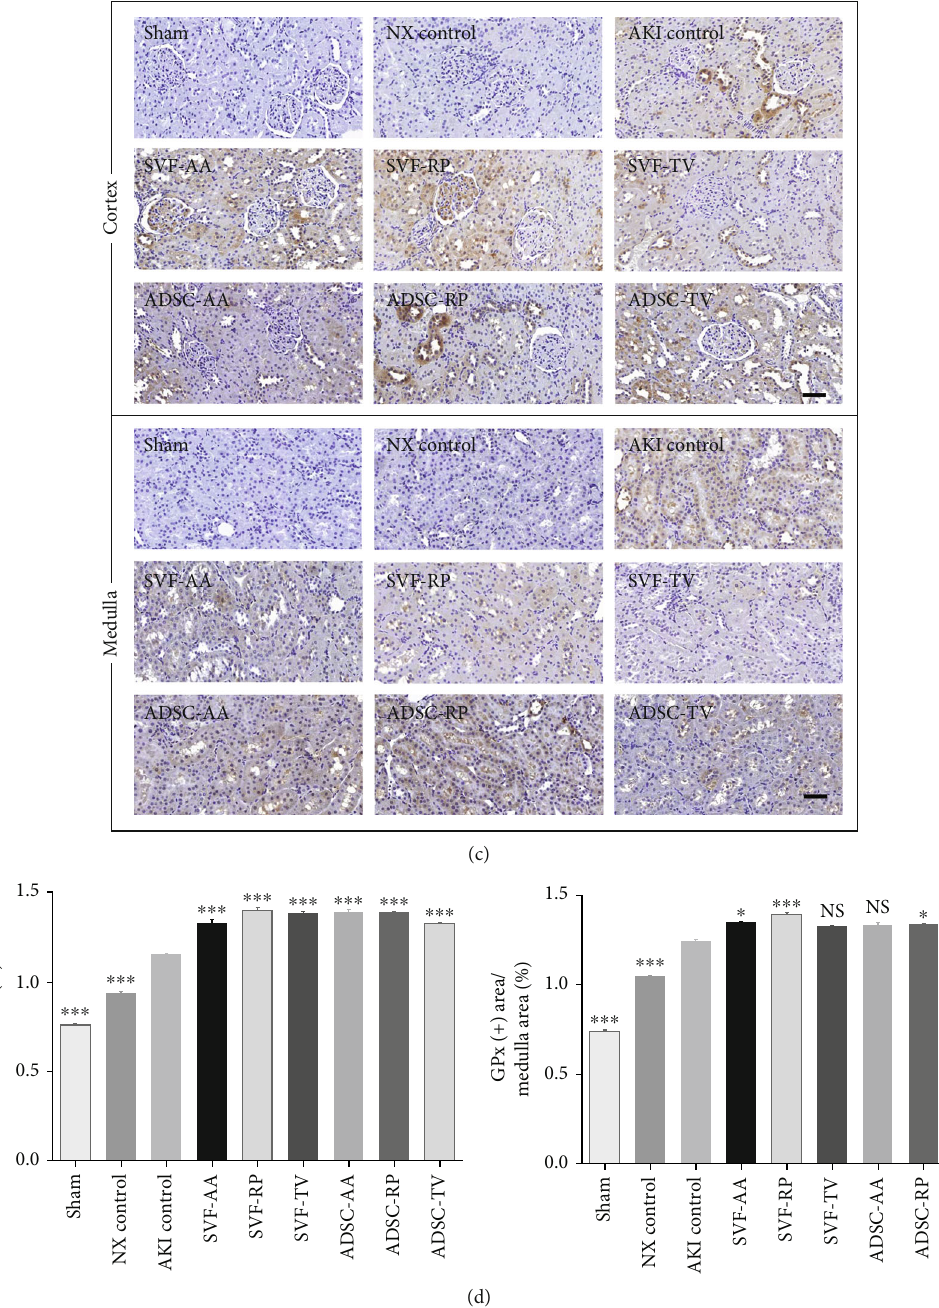
Figure 9: Antioxidation markers of kidney tissue. (a) Representative photomicrographs of cortex and medulla in GR. (b) Ratio of area stained positive for GR to random cortex area (left) and medulla area (right). (c) Representative photomicrographs of cortex and medulla in GPx. (d) Ratio of area stained positive for GPx to random cortex area (left) and medulla area (right). Magni fi cation × 40. Scale bar 50 μ m. NS, p > 0 : 05 ; ∗ p < 0 : 05 ; ∗∗ p < 0 : 01 ; ∗∗∗ p < 0 : 001 compared to the AKI control group. 4 fi elds per rat; 10 rats per group, but 8 rats in the SVF-AA and ADSC-AA